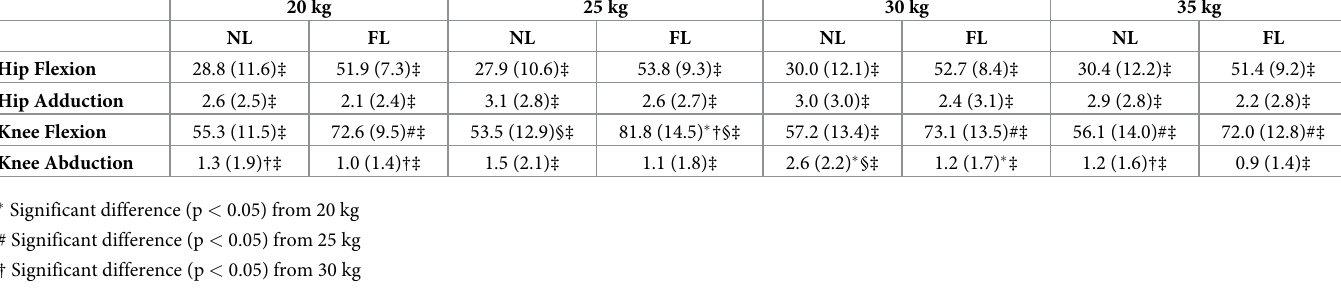
Table 2. Mean (SD) joint range of motion (˚) during normal (NL) and flexed (FL) drop landings. 20